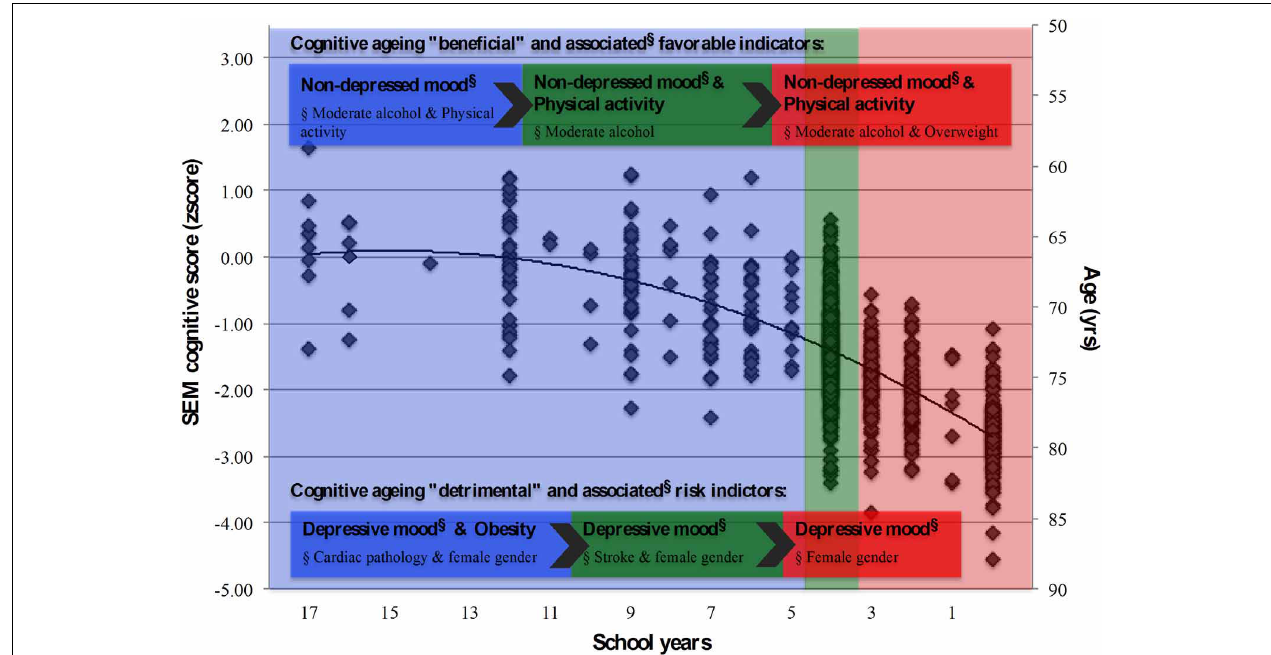
FIGURE 4 | Summary model for the latent cognition score (SEM) and associated structural and lifestyle, physical and clinical indicators. School groups“morethan4,”“4,”and“lessthan4”schoolyears,representedinblue,